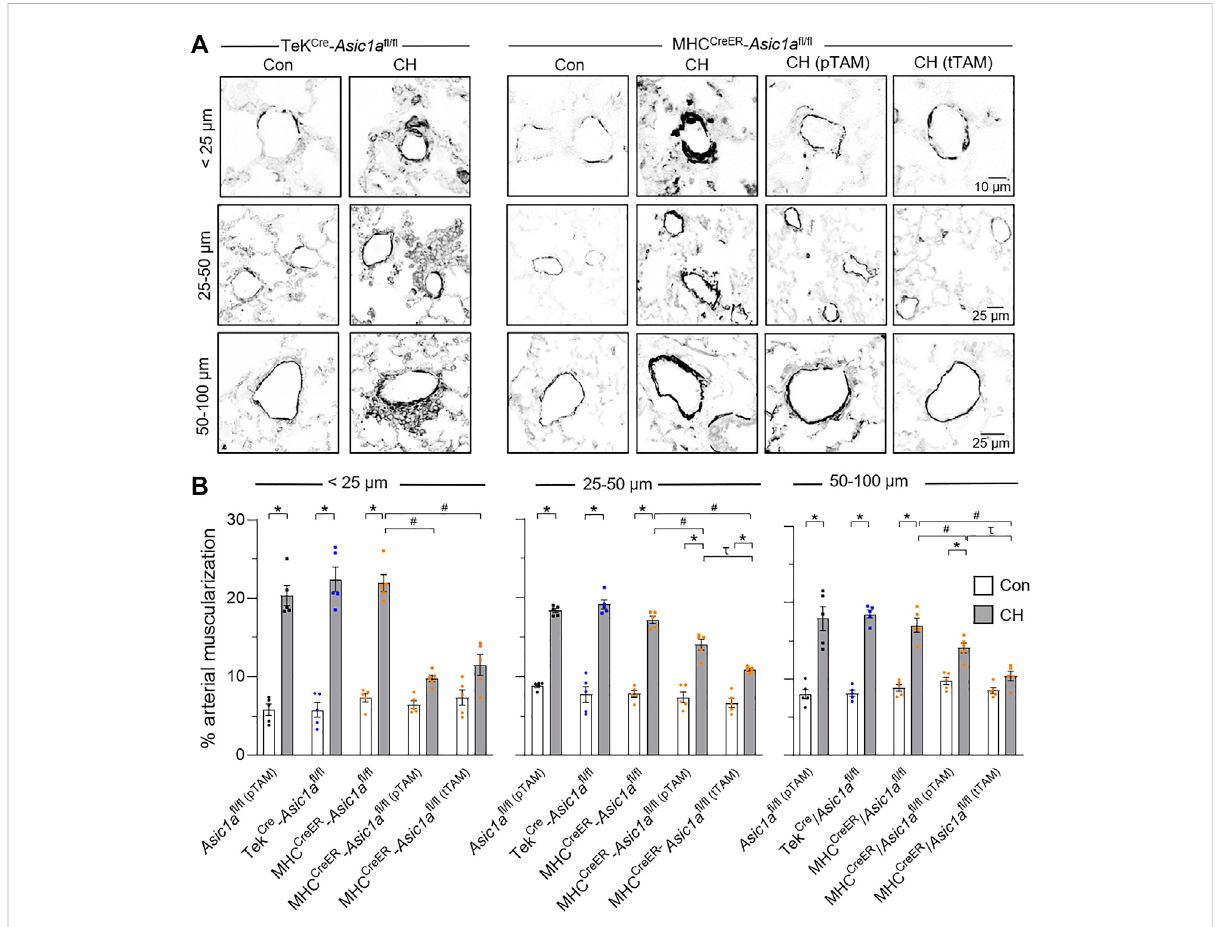
FIGURE 5 SM ASIC1a contributes to vascular remodeling following CH. (A) Representative SMA immuno fl uorescence (black) images of small pulmonary arteries in lung sections from TekCre- Asic1a fl / fl , MHC CreER - Asic1a fl / fl , MHC CreER - Asic1a fl / fl (pTAM) , or MHC CreER - Asic1a fl / fl (tTAM) mice under control conditions (white bars) or following 6 weeks CH ( fi lled bars). Fluorescence images were digitally inverted to provide better contrast and visibility of immuno fl uorescence. (B) Percent muscularization calculated as percent thresholded SMA area divided by total arterial area based on arterial diameter: < 25 μ m(n=~30vesselsfromfour animals/group),25 – 50 μ m(n=~100 vessels fromfouranimals/group), or50 – 100 μ m (n=~50vessels from four animals/group); analyzed by two-way ANOVA. Signi fi cant interactions between the individual groups ( p < 0.0001 for all vessel diameter ranges) compared with Š ídák ’ s multiple comparisons tests. * p < 0.05 vs. control; # p < 0.05 vs. (-) TAM; and τ p < 0.05 pTAM vs.